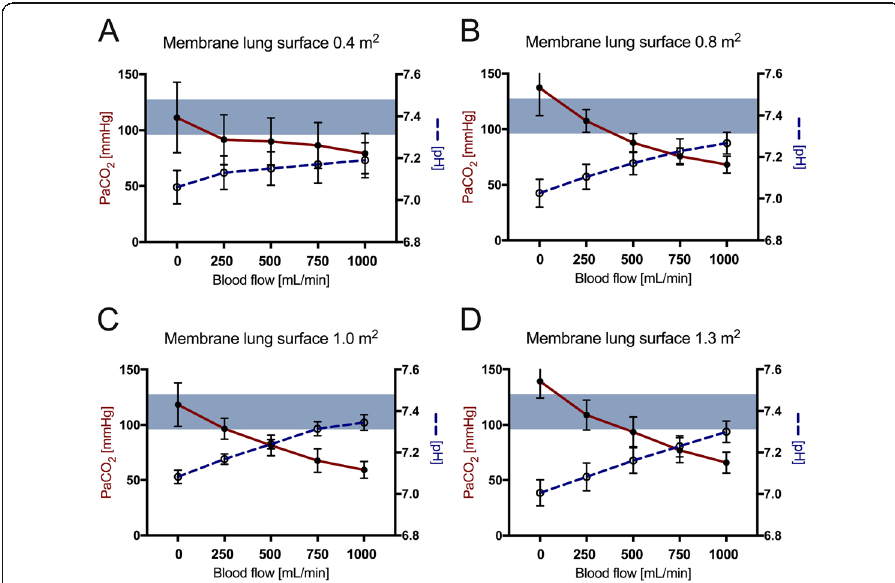
Fig. 4 Partial pressure of arterial carbon dioxide (PaCO 2 / red line ) and corresponding pH value ( blue dotted line ) depending on blood flow. Membrane lung surface ranges from 0.4 m 2 ( a ), 0.8 m 2 ( b ), 1.0 m 2 ( c ) to 1.3 m2 ( d ) with a sweep gas flow of 8 L O 2 /min. Blood flow was titrated from 250 to 1000 ml/min. Each data point represents the mean and standard deviation of seven